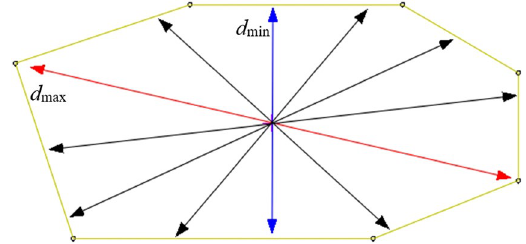
Figure 1. Measurement of the size of a